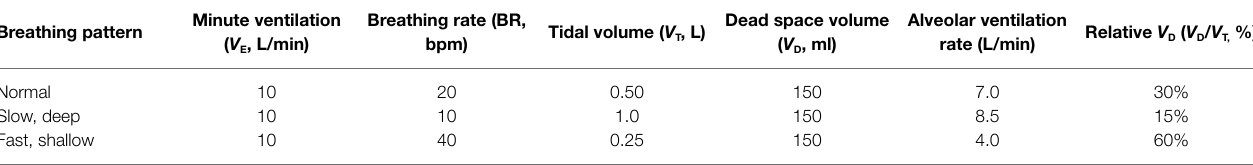
TABLE 2 | Effect of breathing pattern on alveolar ventilation and dead space in three scenarios. Adapted from Braun (1990). Breathing